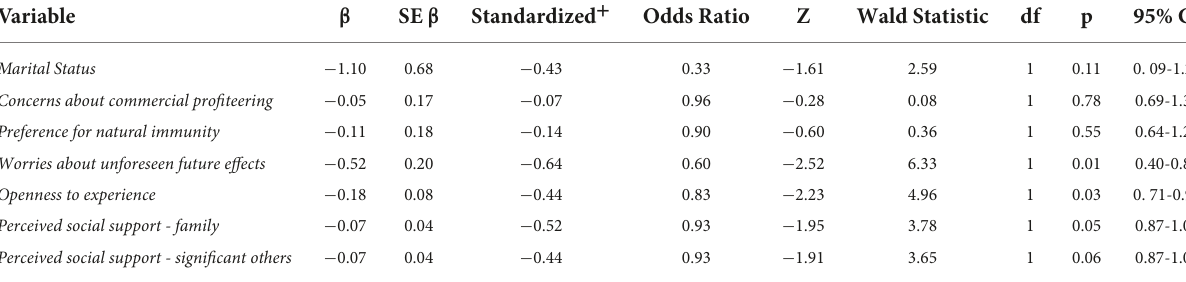
TABLE 5 Multivariable logistic regression analysis with COVID-19 vaccine uptake as outcome variable.